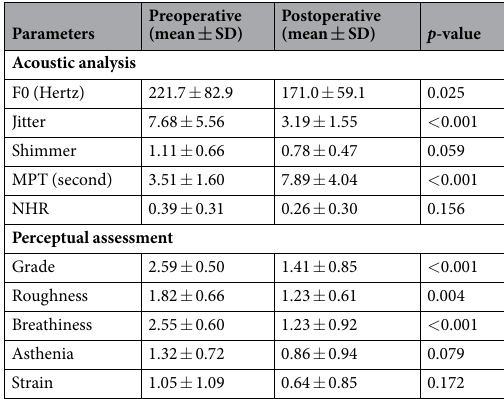
Table 2. Comparison of speech and voice parameters recorded preoperatively and